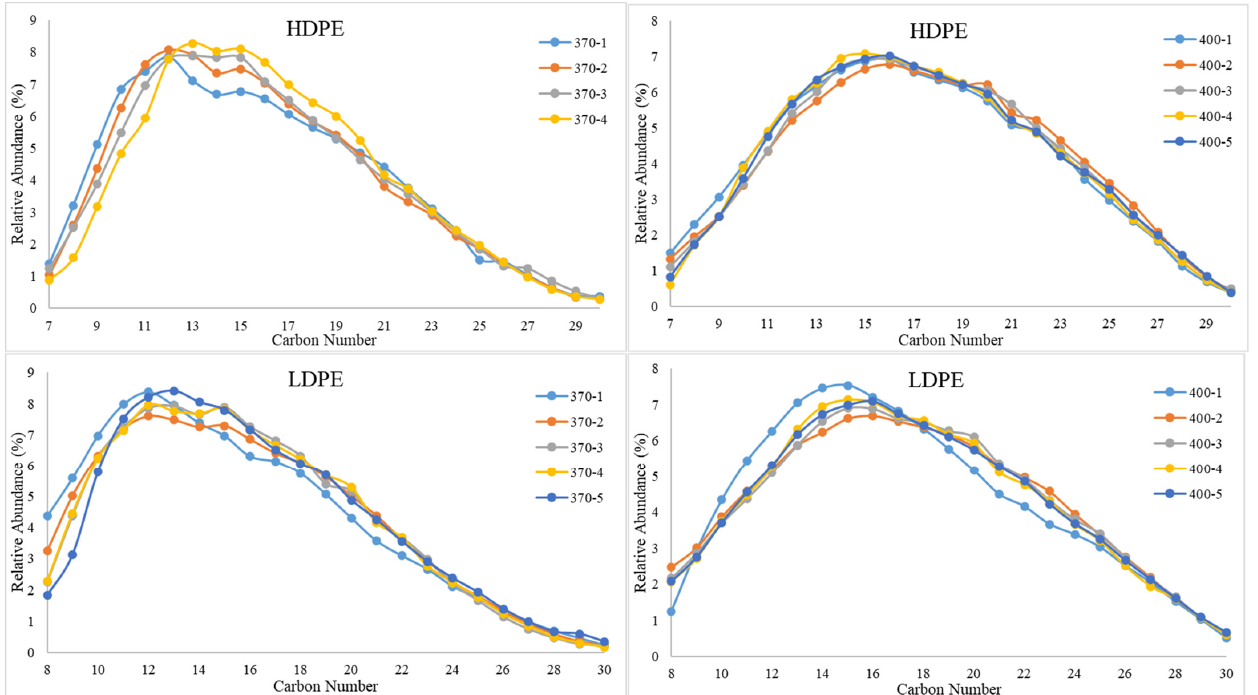
Figure 7. Relative abundances of C 8 –C 30 hydrocarbons for PDFO as a function of temperature and sample time for HDPE waste ( top ) and LDPE waste ( bottom ). Note, sample naming convention, “Temperature-Sample Number”; i.e., “370-1” indicates the first sample collected at 370 °C. Samples were collected every hour.